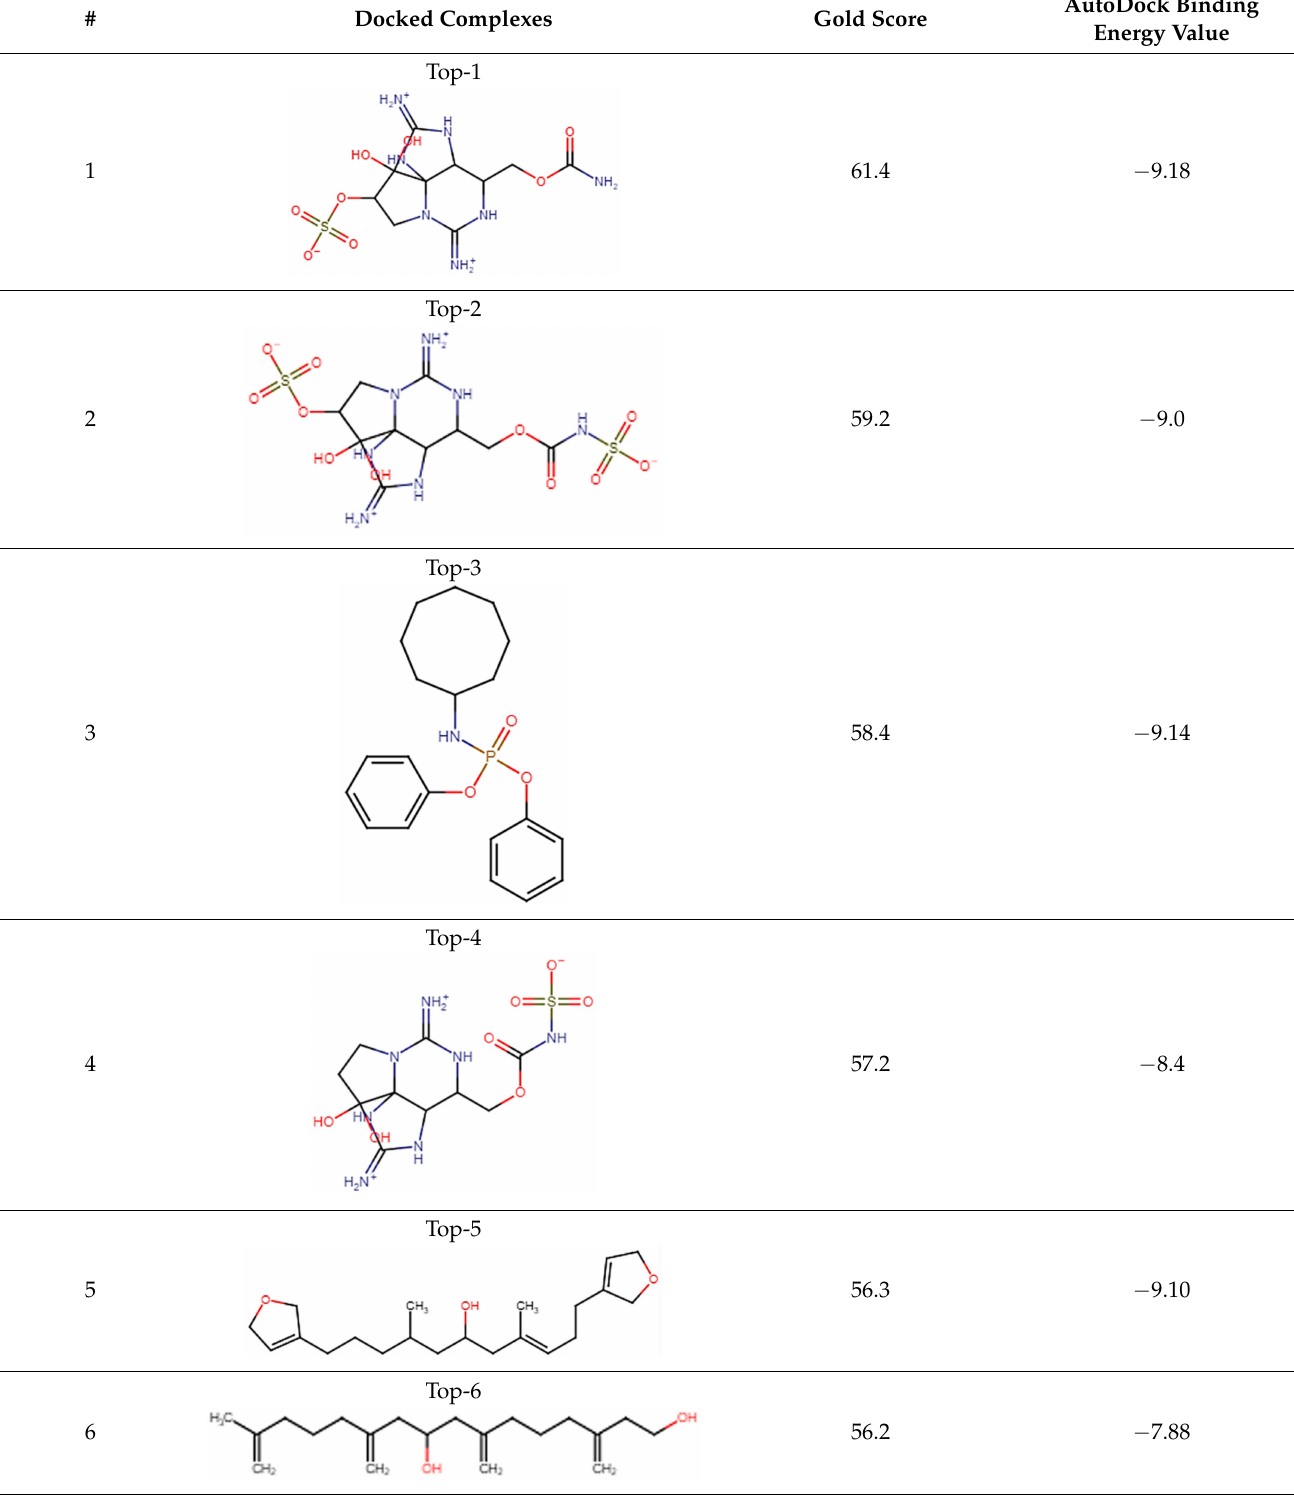
Table 1. GOLD fitness score and binding free energy of compounds for the MvfR